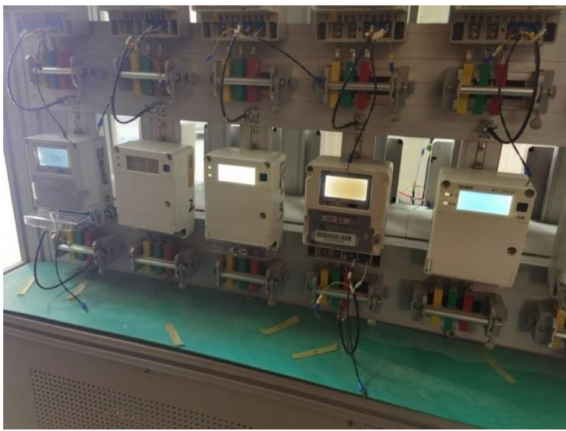
Figure 16. Abnormal display of the sample table.